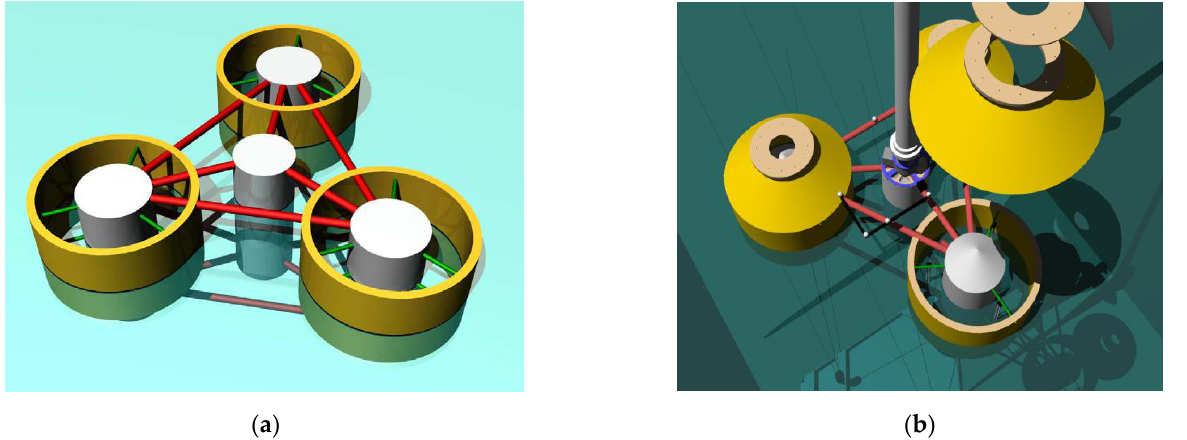
Figure 2. Three-dimensional (3D) representation of the REFOS floater: ( a ) without the oscillating water column (OWC) domes; ( b ) with the conical OWC domes. Table 1. Floating platform